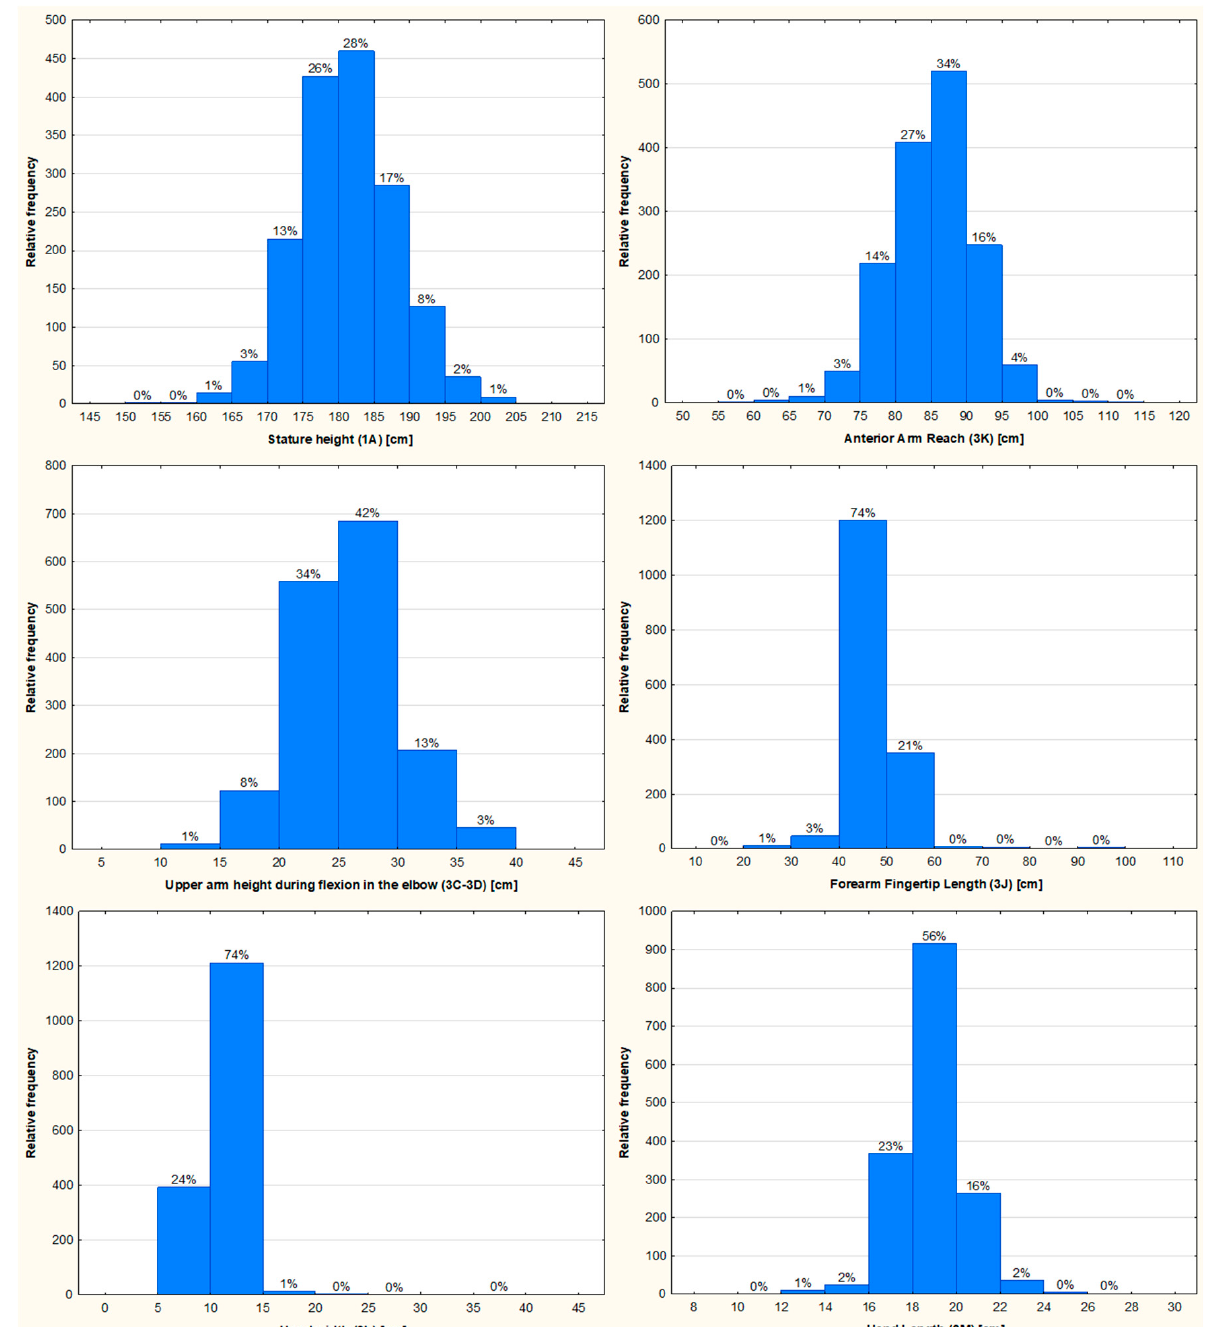
Figure 3. Histograms of analyzed selected anthropometric dimensions.